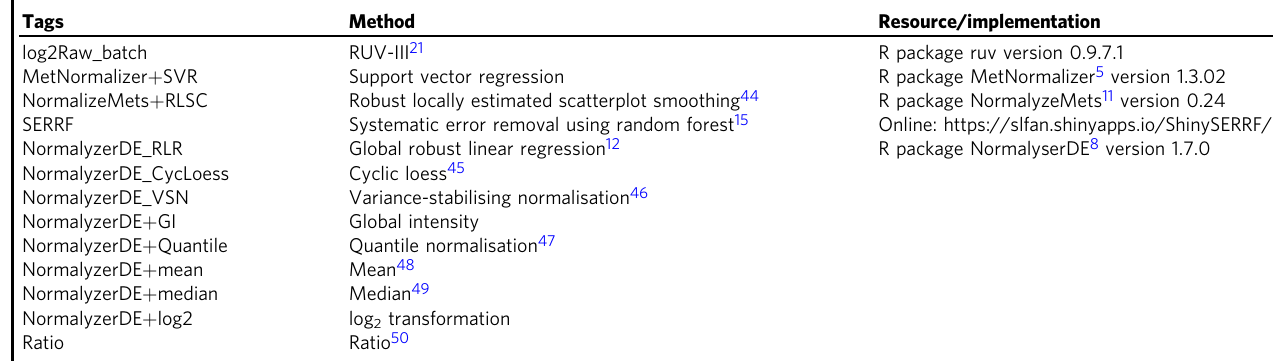
Table 1 List of existing normalisation